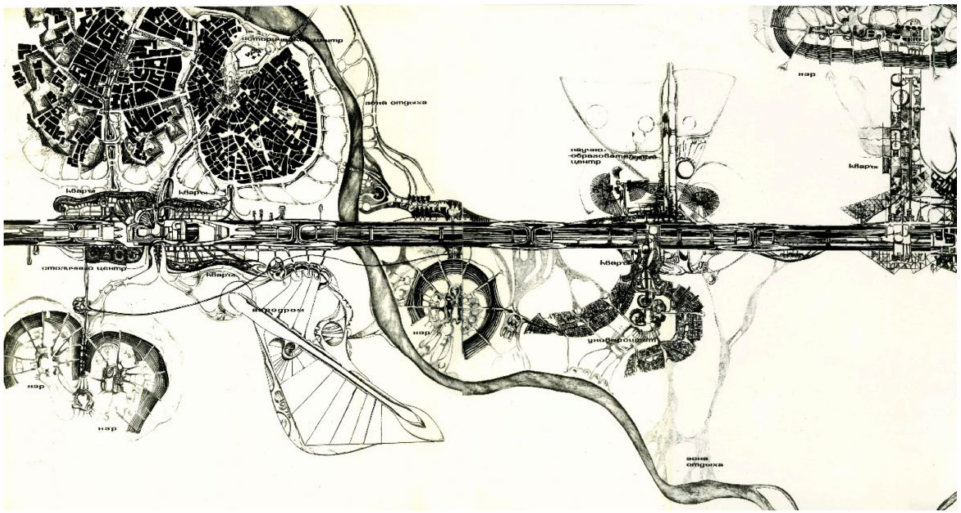
Figure 2. Fragment of the system of new settlement elements and transcontinental connections, according to A. Baburov, A. Gutnov, I. Lezhava, S. Sadovsky, Z. Kharitonova, and G. Dumengton [31].